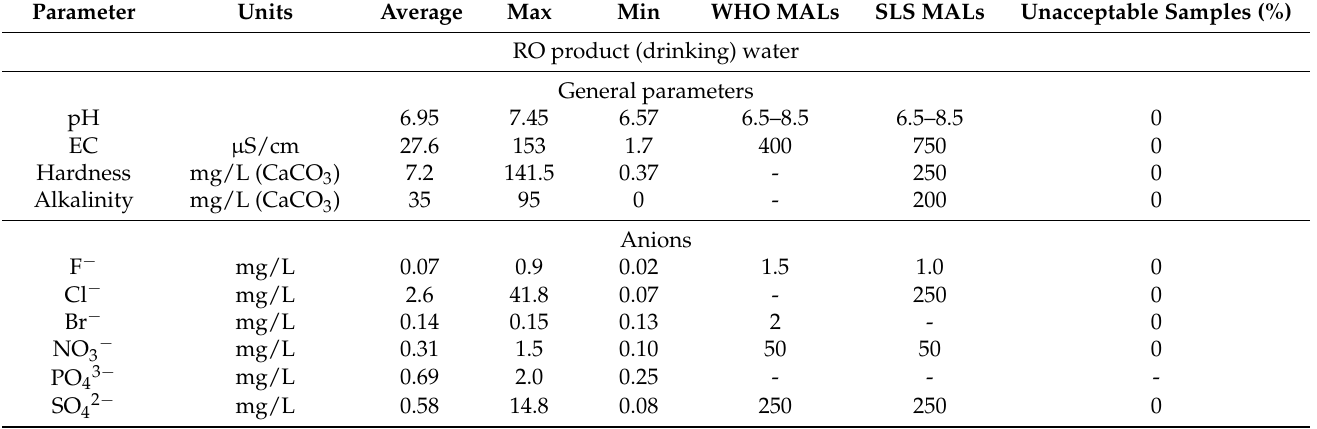
Table 2. Product water quality from RO stations in NCP with the comparison of drinking water quality standards (WHO and